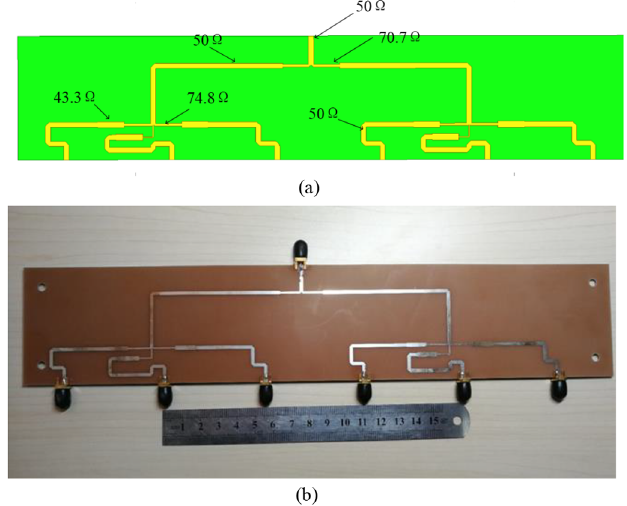
Fig. 6. Perspective view of the BSAA with PRS and feeding network.